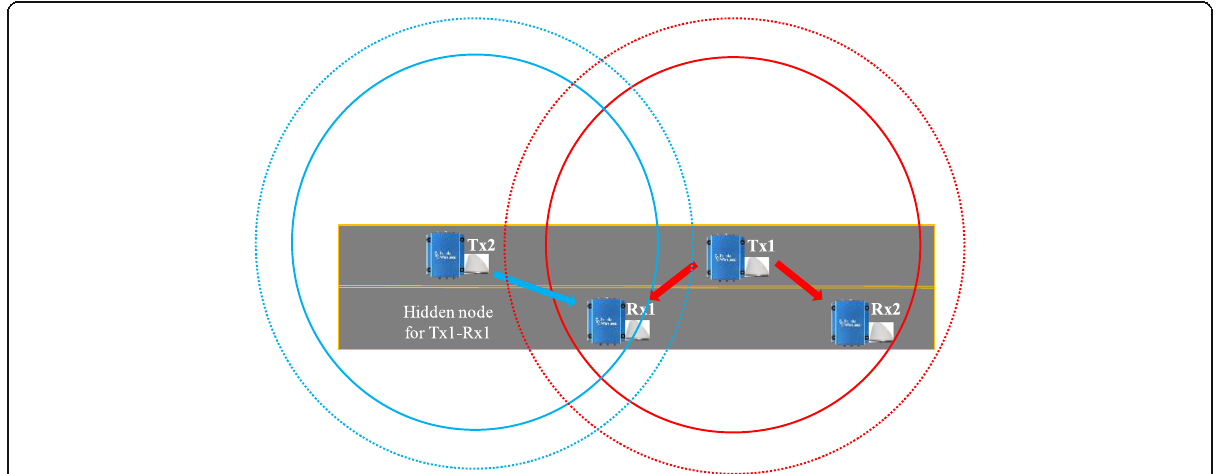
Fig. 8 Four nodes test network of the commercial devices emulating the hidden terminal